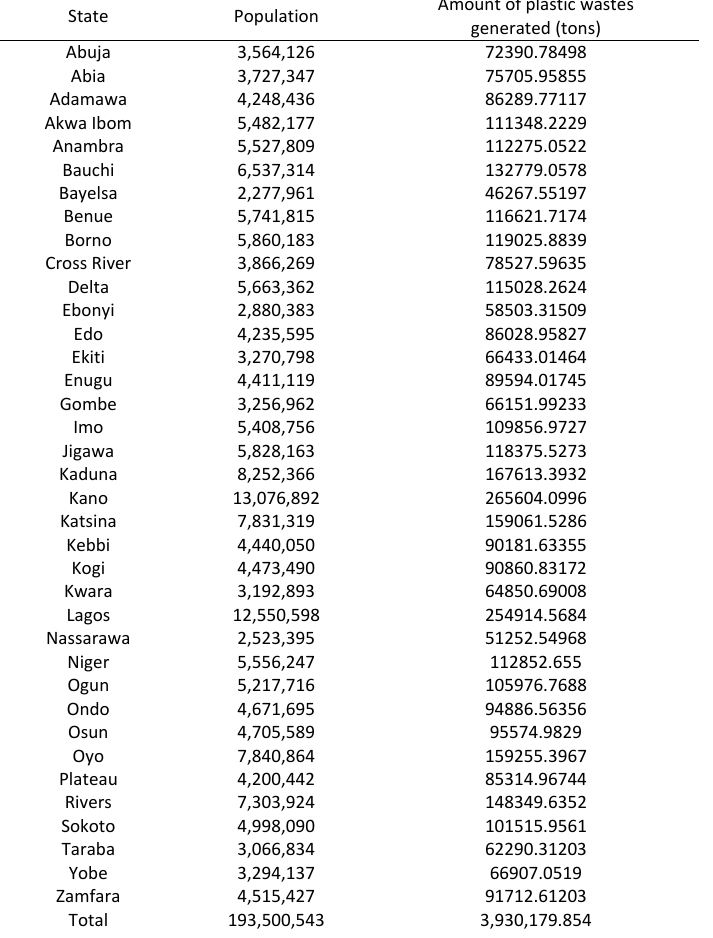
Table 2: Plastic wastes generation in Nigerian States and FCT in 2016 (NBS, 2017)